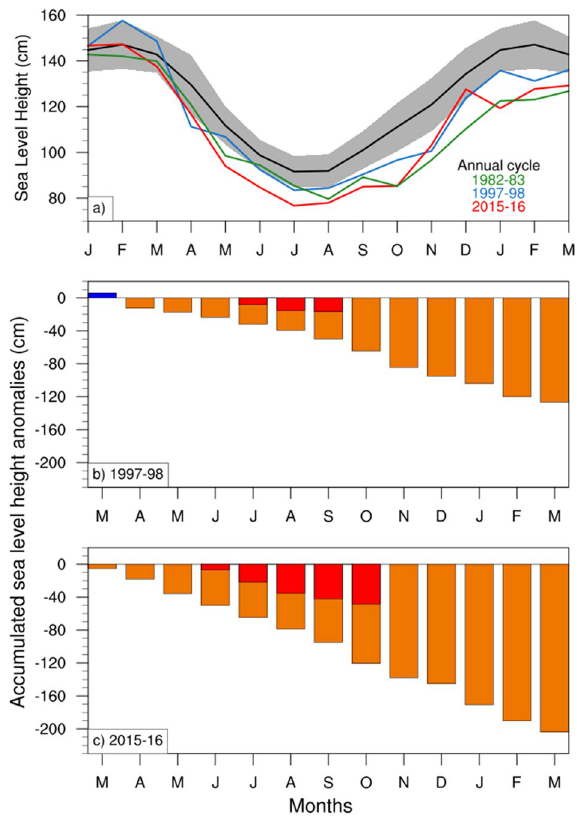
Figure 5. ( a ) Sea level height (SLH, in cm) evolution at the Gulf of Carpentaria during Strong El Niño events, along with the climatological annual cycle (black curve) and its two-standard deviation (2 σ ) range (grey shading). ( b,c ) Accumulation of drop-in SLH anomalies during two recent strong El Niño events (1997-1998 and 2015-2016, respectively) are shown as orange bars. The similar accumulation relative to climatological minima is denoted by red bars. The linear trend is removed from the SLH data before the analysis. Plots are generated using the NCAR Command Language version 6.6.2 (http:// www. ncl. ucar. edu/).